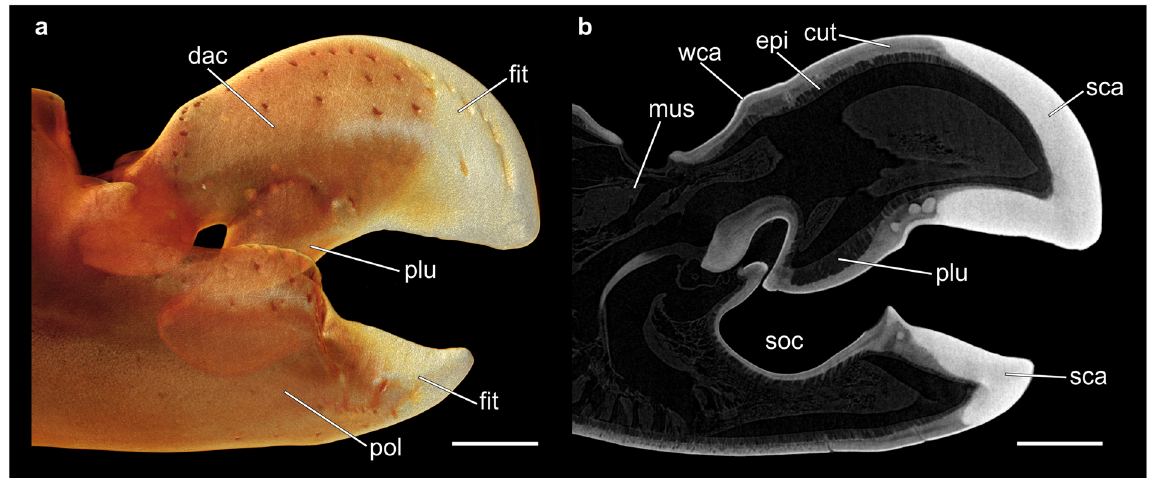
Figure 4. Calcification pattern of the extant alpheid snapping claw. ( a ) µ CT-based volume rendering of the snapping claw of Alpheus bisincisus , preserved specimen (NHMW-CR-25767). ( b ) Virtual sagittal section through the same µ CT dataset illustrating differences in X-ray absorption caused by different degrees of cuticular calcification. Scale bars equal 1 mm. cut = cuticle, dac = dactylus, epi = epidermis, fit = fingertip, mus = muscle, plu = plunger, pol = pollex, sca = strong calcification, soc = socket, wca = weak